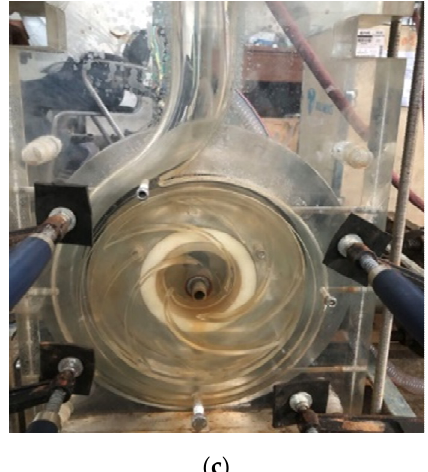
Figure 4. ( a ) Impeller mode of cylindrical blades; ( b ) impeller model of splitter blades; ( c ) on-site physical pump model.